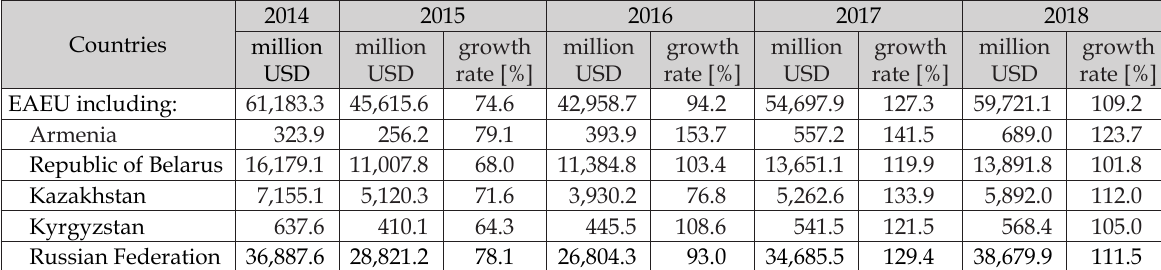
Table 1. Dynamics of the EAEU mutual merchandise